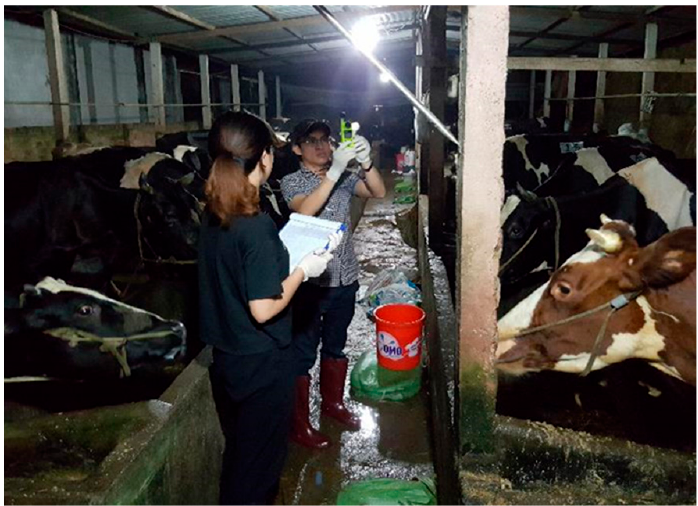
Figure 2. Measurement of microclimate data inside cowsheds. Based on AT, cows were predicted to be normal when AT < 20 ◦ C, at the heat stress threshold when 20 ◦ C ≤ AT < 27 ◦ C and suffering mid-severe heat stress (feed intake decreases and welfare is disturbed) when AT ≥ 27 ◦ C